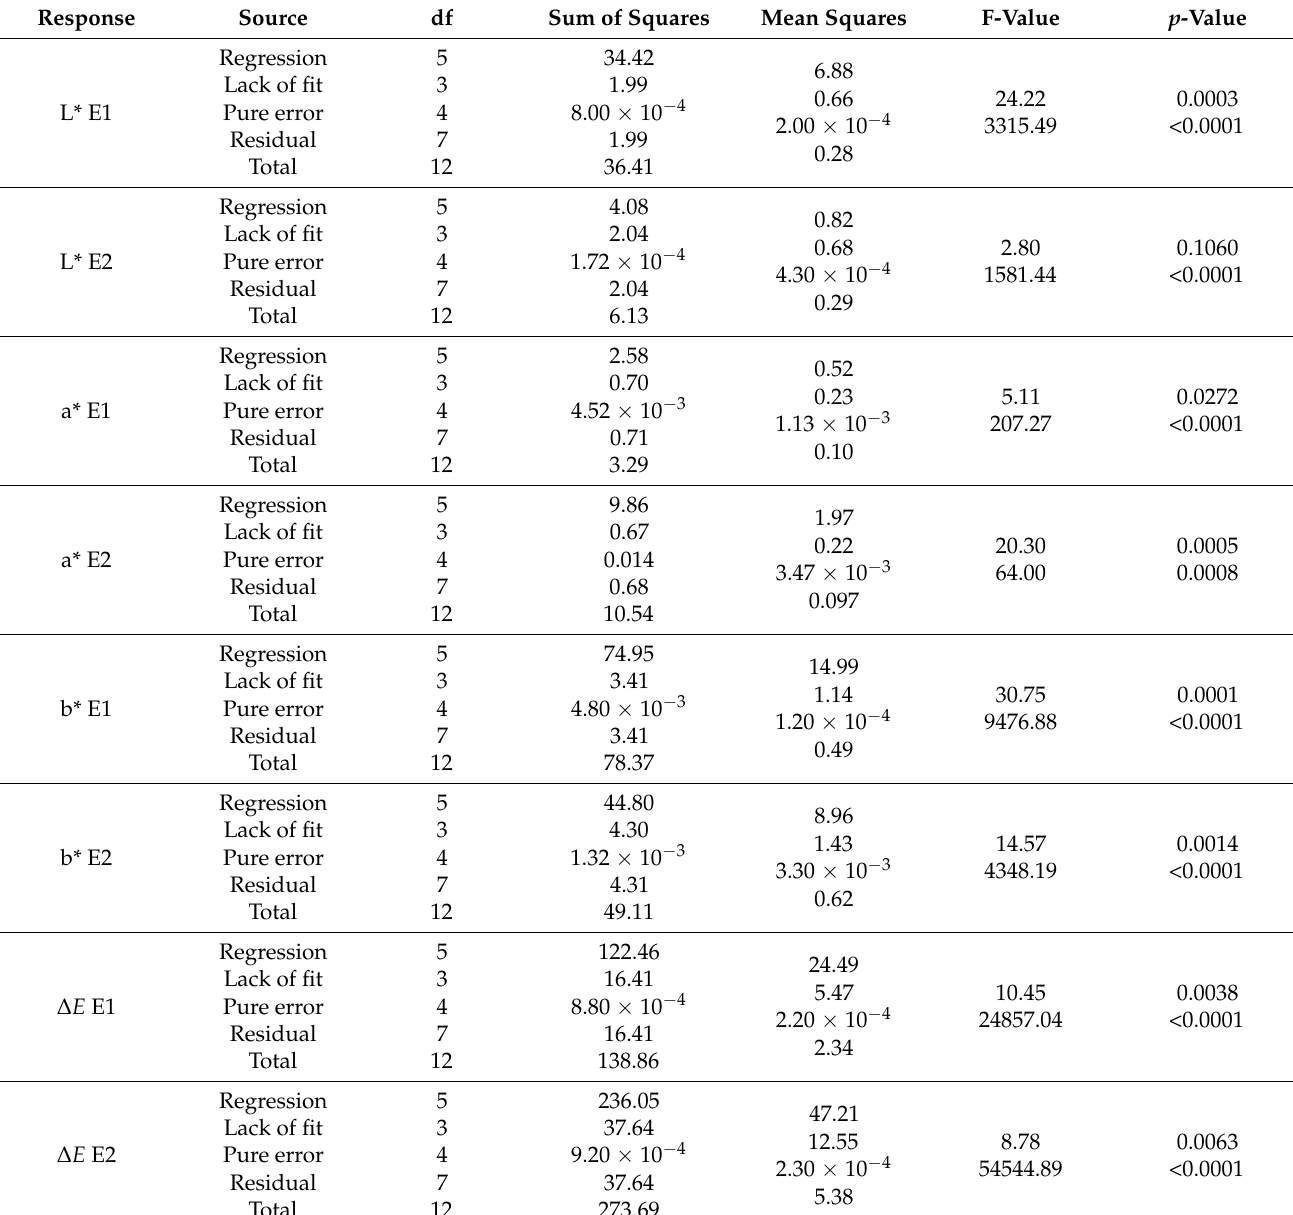
Table 5. Analysis of variance results for fitted models of product properties *.